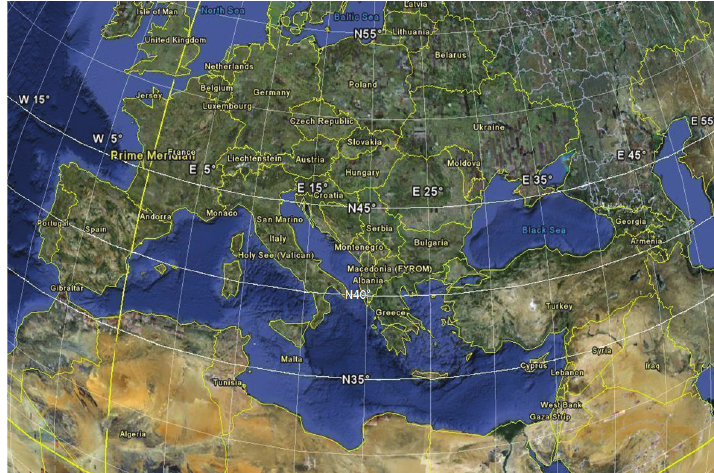
Figure 1: The latitude lines of the Mediterranean basin countries (from Google